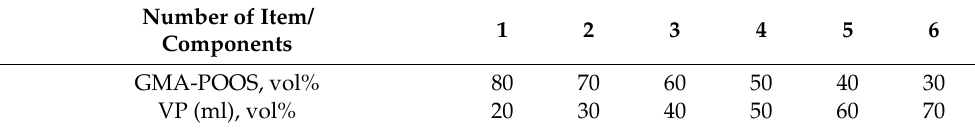
Table 1. Parameters of sample